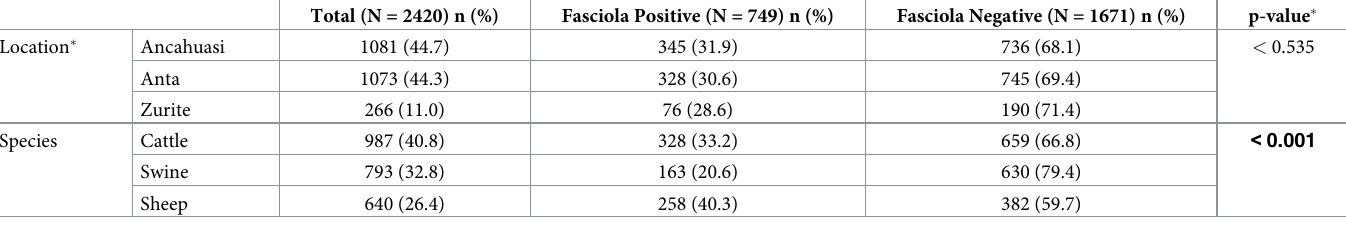
Table 2. “Distribution of the livestock samples and comparison between Fasciola positive and negative samples “. Total (N = 2420) n